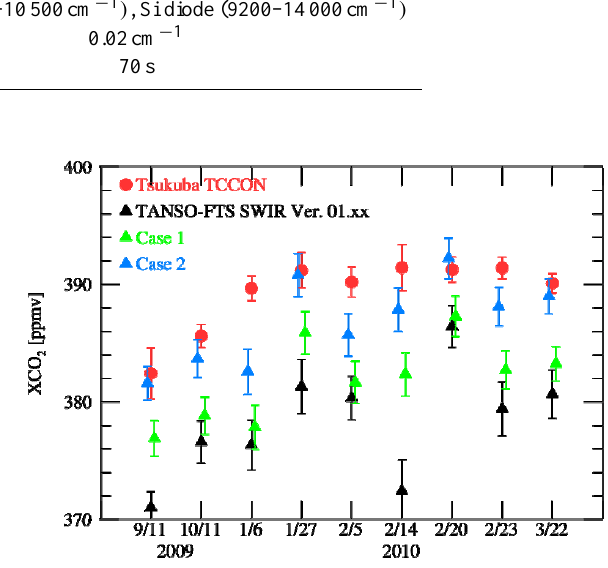
Fig. 1. Comparison of TANSO-FTS SWIR XCO 2 (Ver. 01.xx) data with the Tsukuba TCCON, Case 1 and Case 2 XCO 2 results. Fig. 1. The Case 1 and Case 2 XCO 2 are retrieved using Kurucz’s and Toon’s solar irradiance data, respectively. Both cases are taking into account the vertical profiles of two types of aerosols and cirrus clouds determined from lidar and sky radiometer (Table 5). The er- ror bars for the Tsukuba TCCON data and the retrieved XCO 2 are also